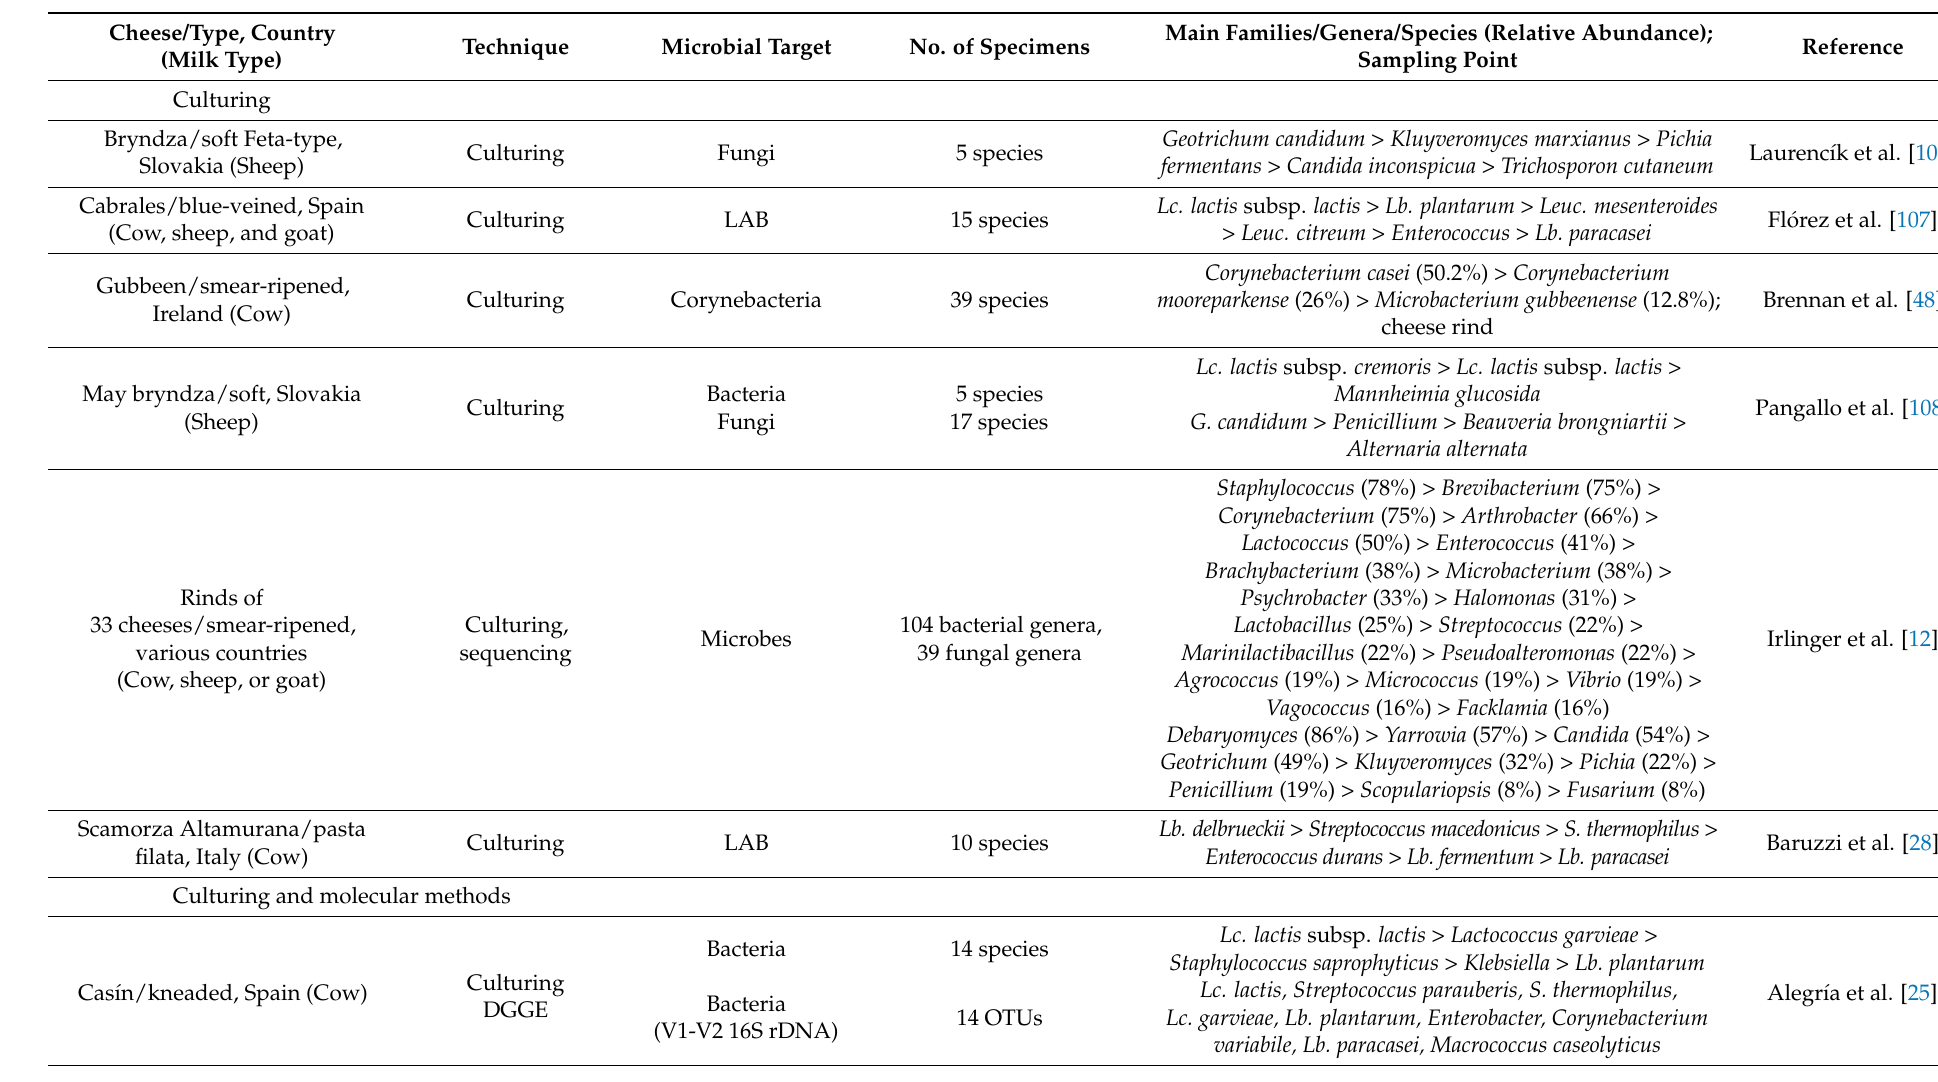
Table 2. Non-exhaustive compilation of microbial studies of traditional cheeses, technologies applied, and dominant populations identified or